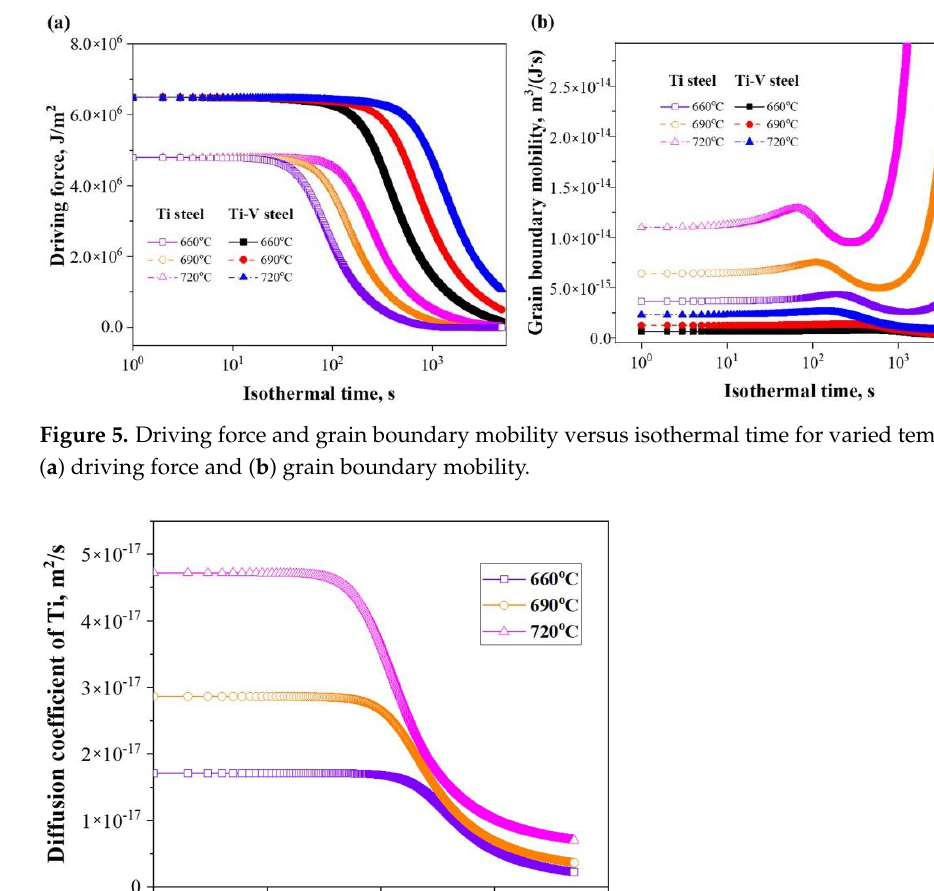
Figure 4. Radius and number density of precipitates during isothermal treatment at different tem- peratures: ( a ) radius of TiC, ( b ) radius of (Ti x ,V 1 − x )C, ( c ) number density of TiC and ( d ) number density of (Ti x ,V 1 − x )C.